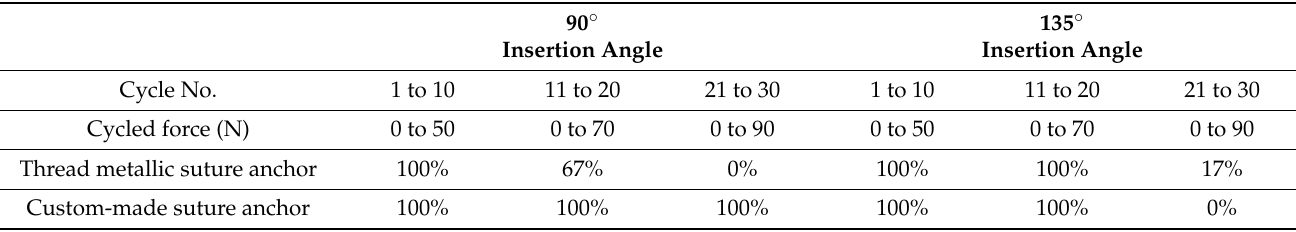
Table 2. Percentage of specimens intact (survived) after cyclic testing.